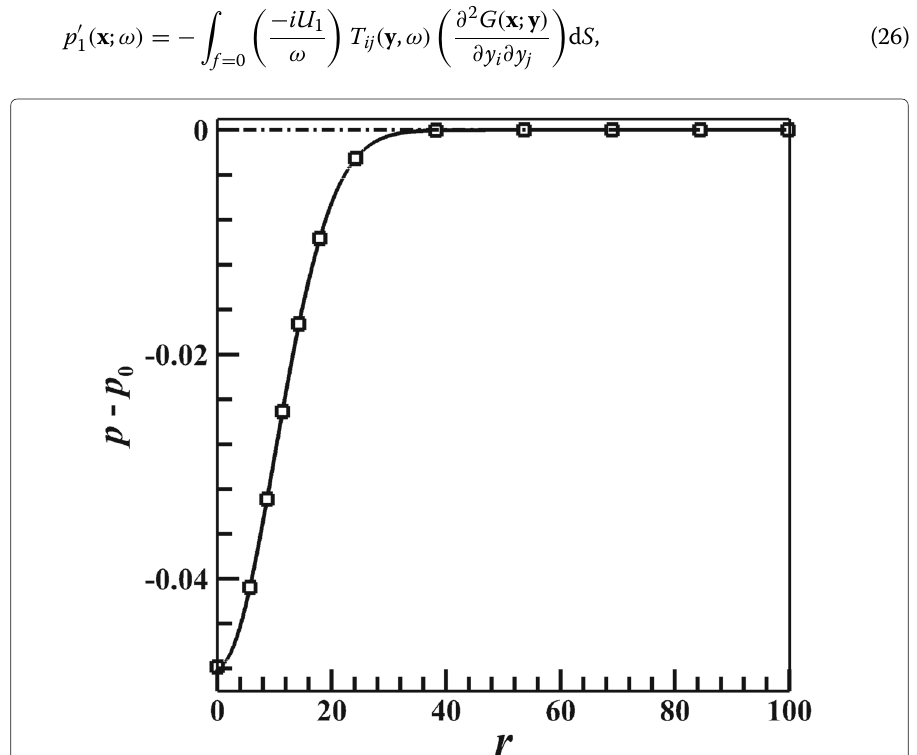
crossing the integral surface. The results shown in Fig. 3 indicate that the approximations of Eq. (4) are correct. To further verify the approximations to the derivatives of Green’s function, we compare the first three terms in Eqs. (3) and (11) in detail as follows. We denote the first, second and third terms in Eq. (3) by